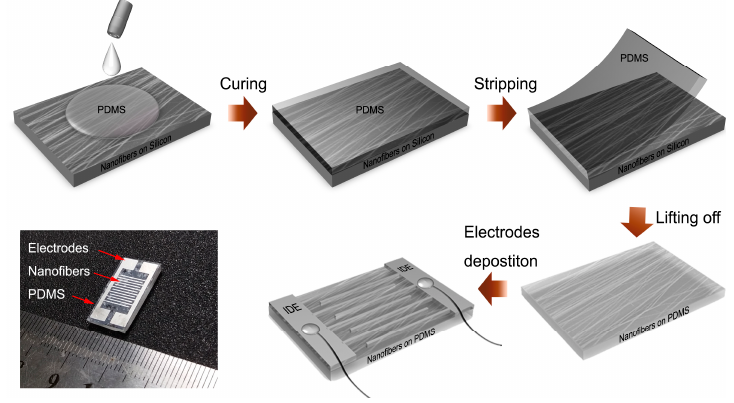
Figure 3. NaNbO 3 NF-based active sensors fabrication procedure.